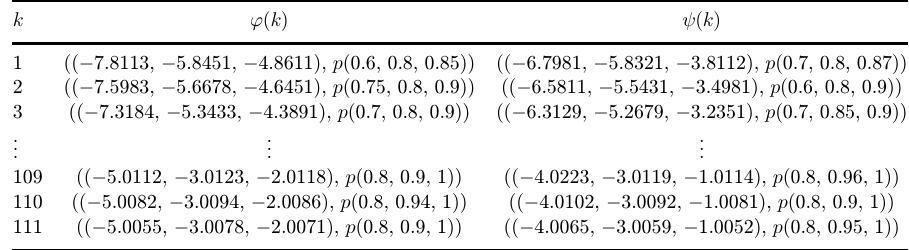
Table 2. Results of approximating the Z -number solutions ’ ð k Þ and ð k Þ with an example feed-forward neural network obtained during the